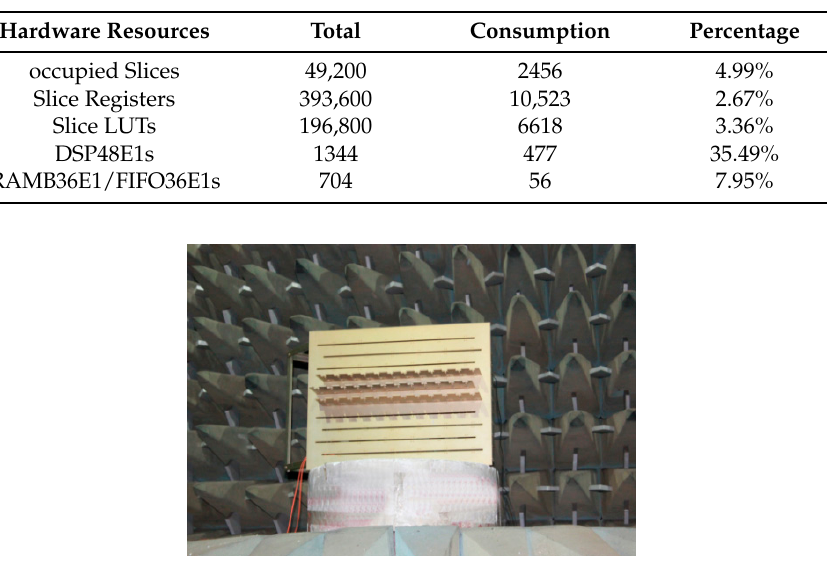
Figure 15. Experiment in a microwave anechoic chamber. Figure 16. Experiment in a microwave anechoic